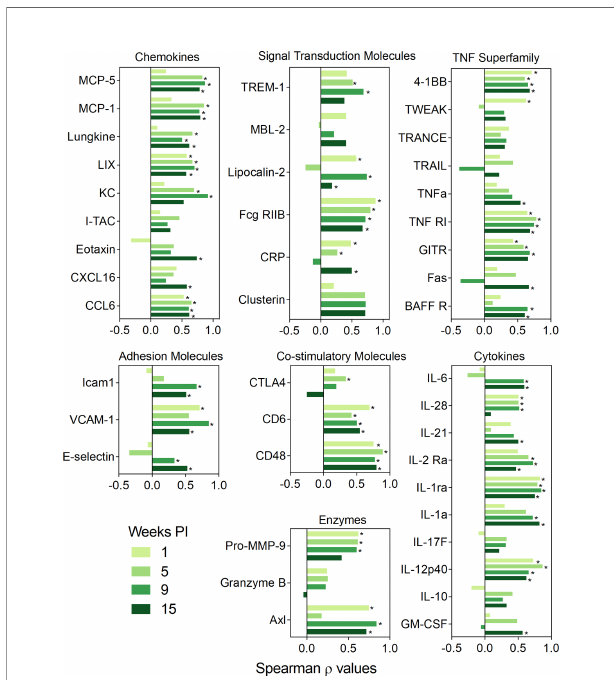
FIGURE 7 | BALF protein responses positively correlate with corresponding lung gene expression. Spearman r values for individual classes of proteins, namely co-stimulatory molecules, adhesion molecules, chemokines, enzymes, signal transduction proteins, growth factors, TNF superfamily proteins, and cytokines were calculated by correlating with corresponding gene expression in individual mice from all experimental groups. Plots are separated by timepoint. Gene expression data were obtained previously using the NanoString Immune Pro fi ling gene panel (35). Bar graph depicting the values of the Spearman correlation coef fi cient. Light green, moderately light green, green and dark green bars indicate 1, 5, 9, or 13 wk PI, respectively. Signi fi cant correlation values (p ≤ 0.05) are designated with